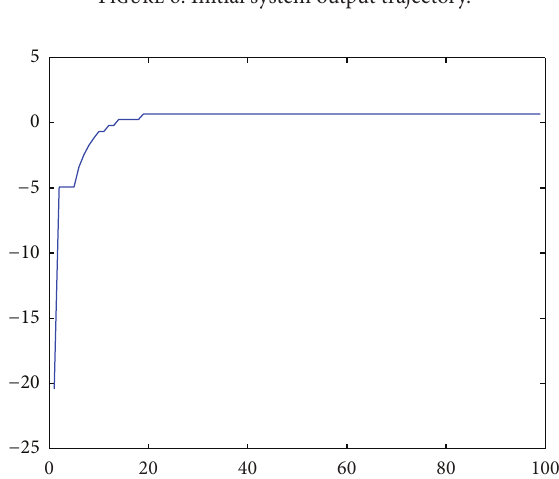
Figure 7: Finial system output